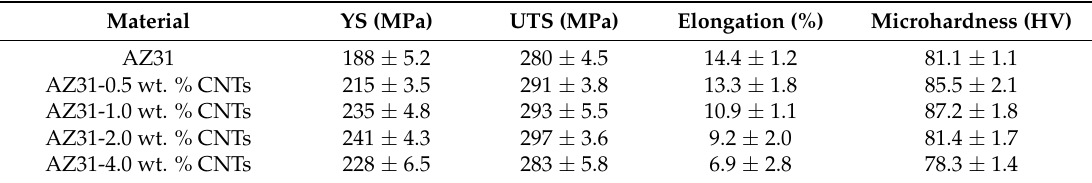
Table 4. Mechanical properties of the as-extruded AZ31 and its